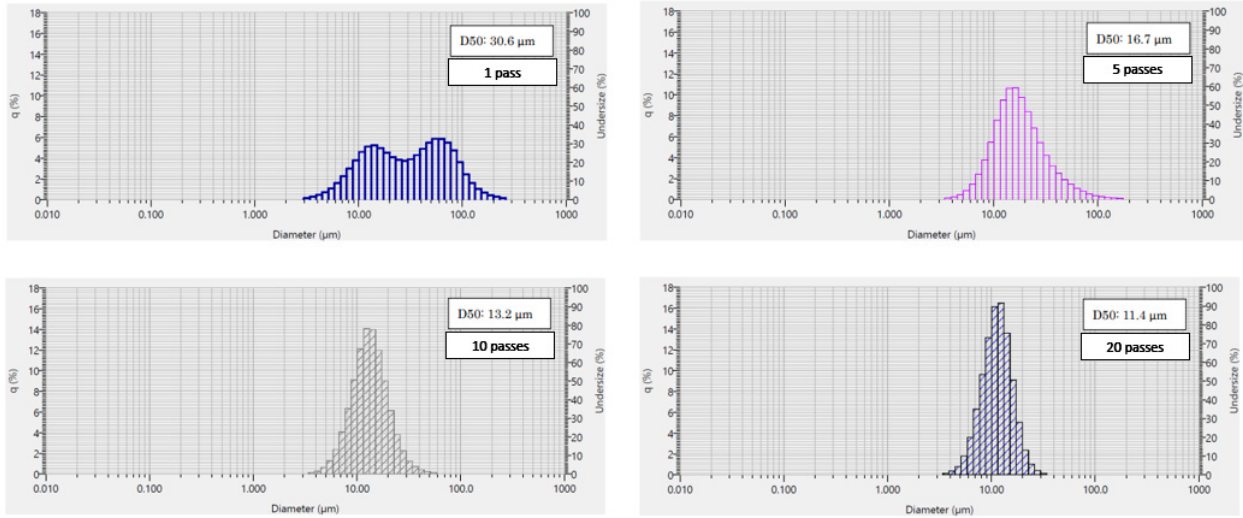
Figure 2. Argan shell granulometry after one, five, ten, and twenty passes of the high-pressure water jet system treatment.